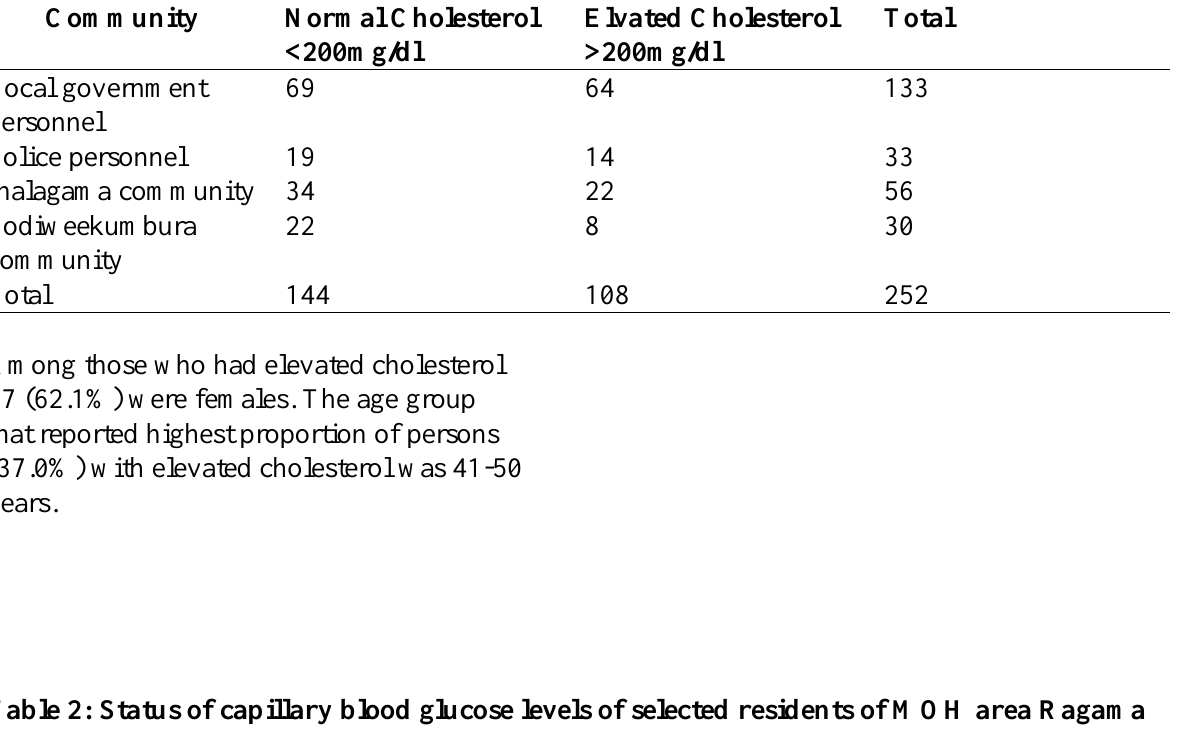
Table 2: Status of capillary blood glucose levels of selected residents of MOH area